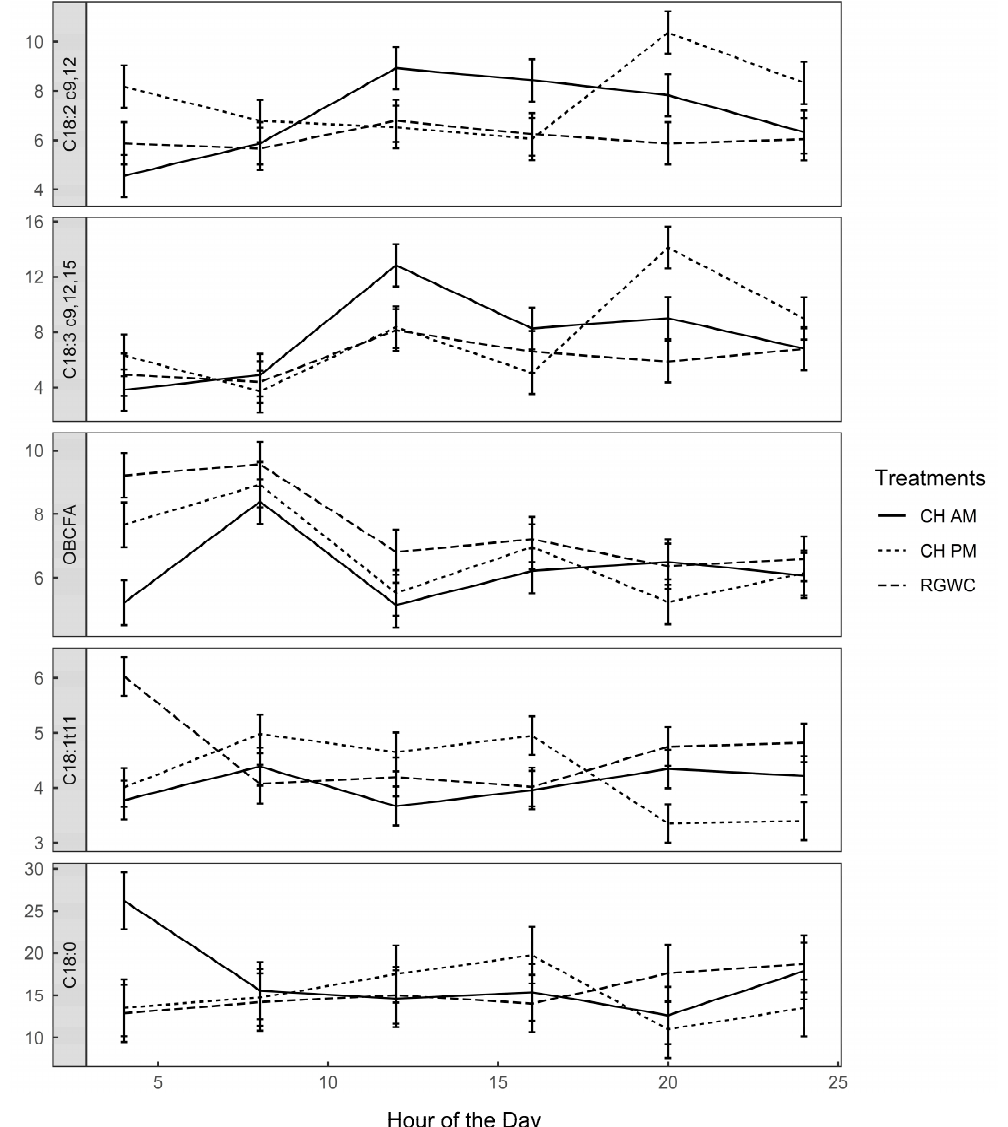
Figure 4. Diurnal variation of rumen fatty acids (g/100 g of total FA). Solid lines denote CHAM (ryegrass/white clover + morning allocation of chicory), short dashed line denotes CHPM (ryegrass/white clover + afternoon allocation of chicory), and long dashed line denote RGWC (perennial ryegrass/white clover only). Error bars are standard error of the mean ( n = 3).